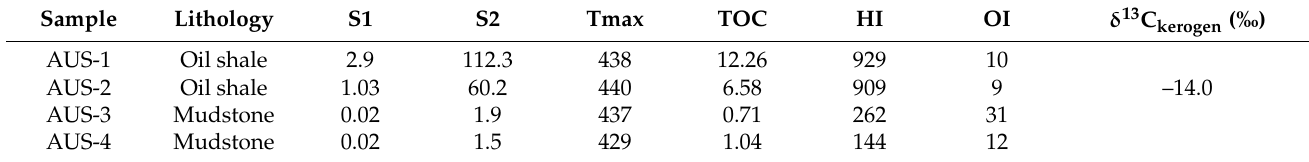
Table 1. Rock-Eval results of oil shale and mudstone samples from the Early Permian in Tasmania, Australia.